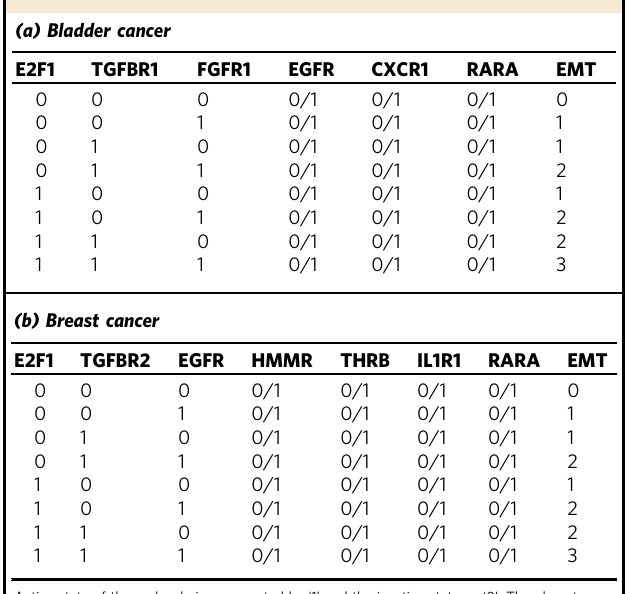
Table 1 The effect of E2F1 and receptor molecules in relevant combinations on the EMT phenotype in bladder and breast cancer model